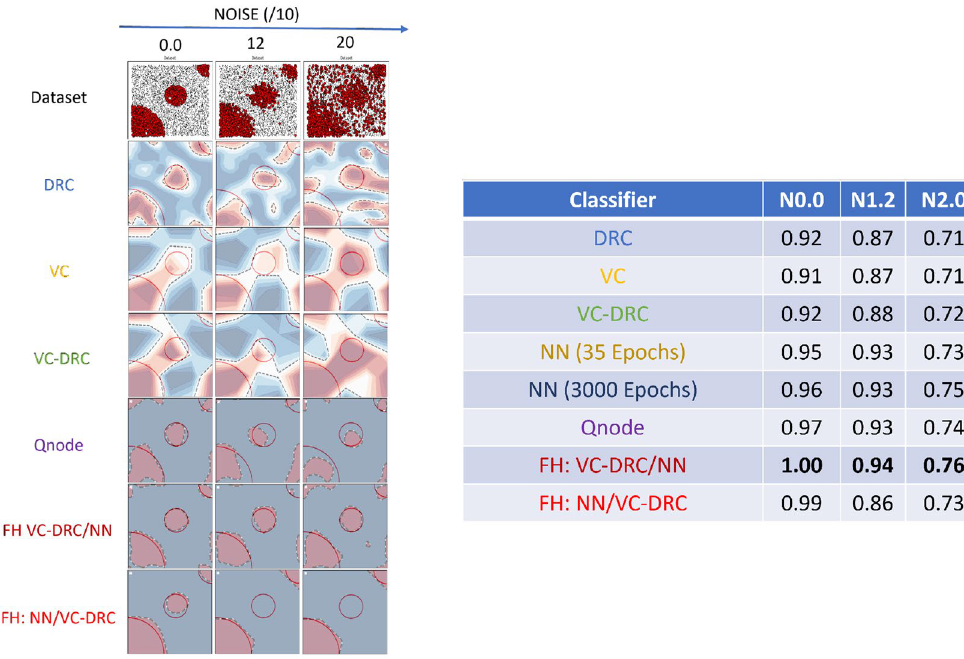
Figure 6. (Right) AUC–ROC curve for classifiers for different noise levels. (Left) Prediction grids for respective classifiers for different noise